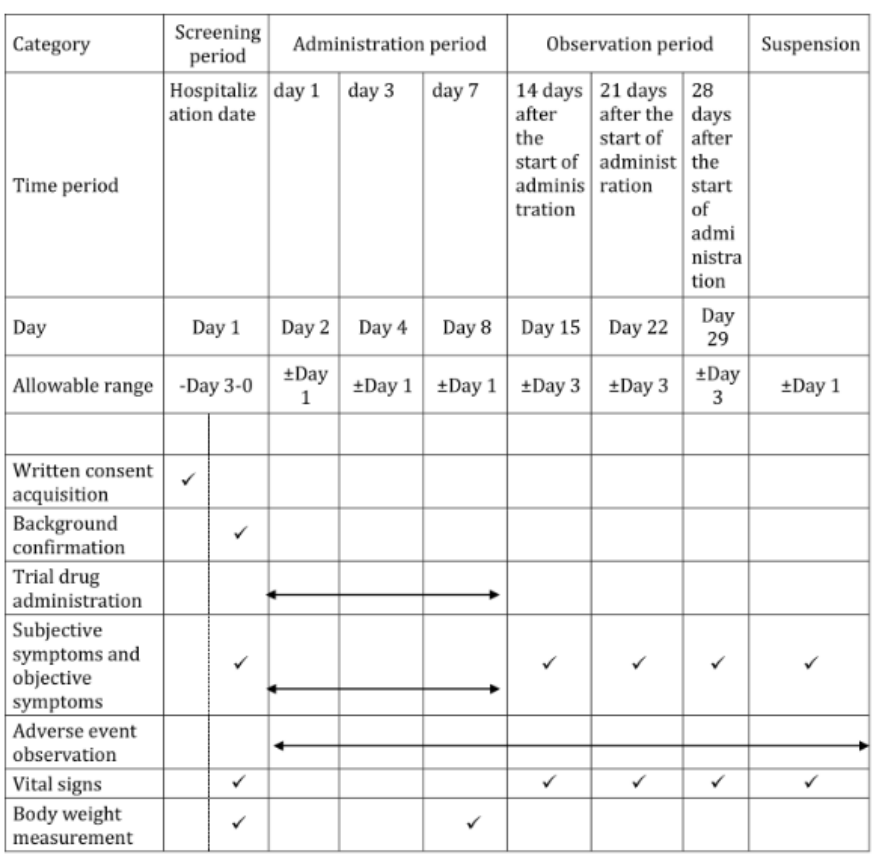
Figure 2. Participant timeline, enrollment, interventions, and